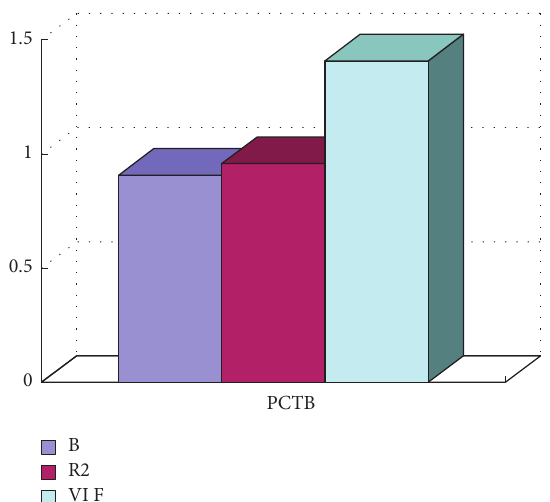
Figure 3: TM regression model of plant background.